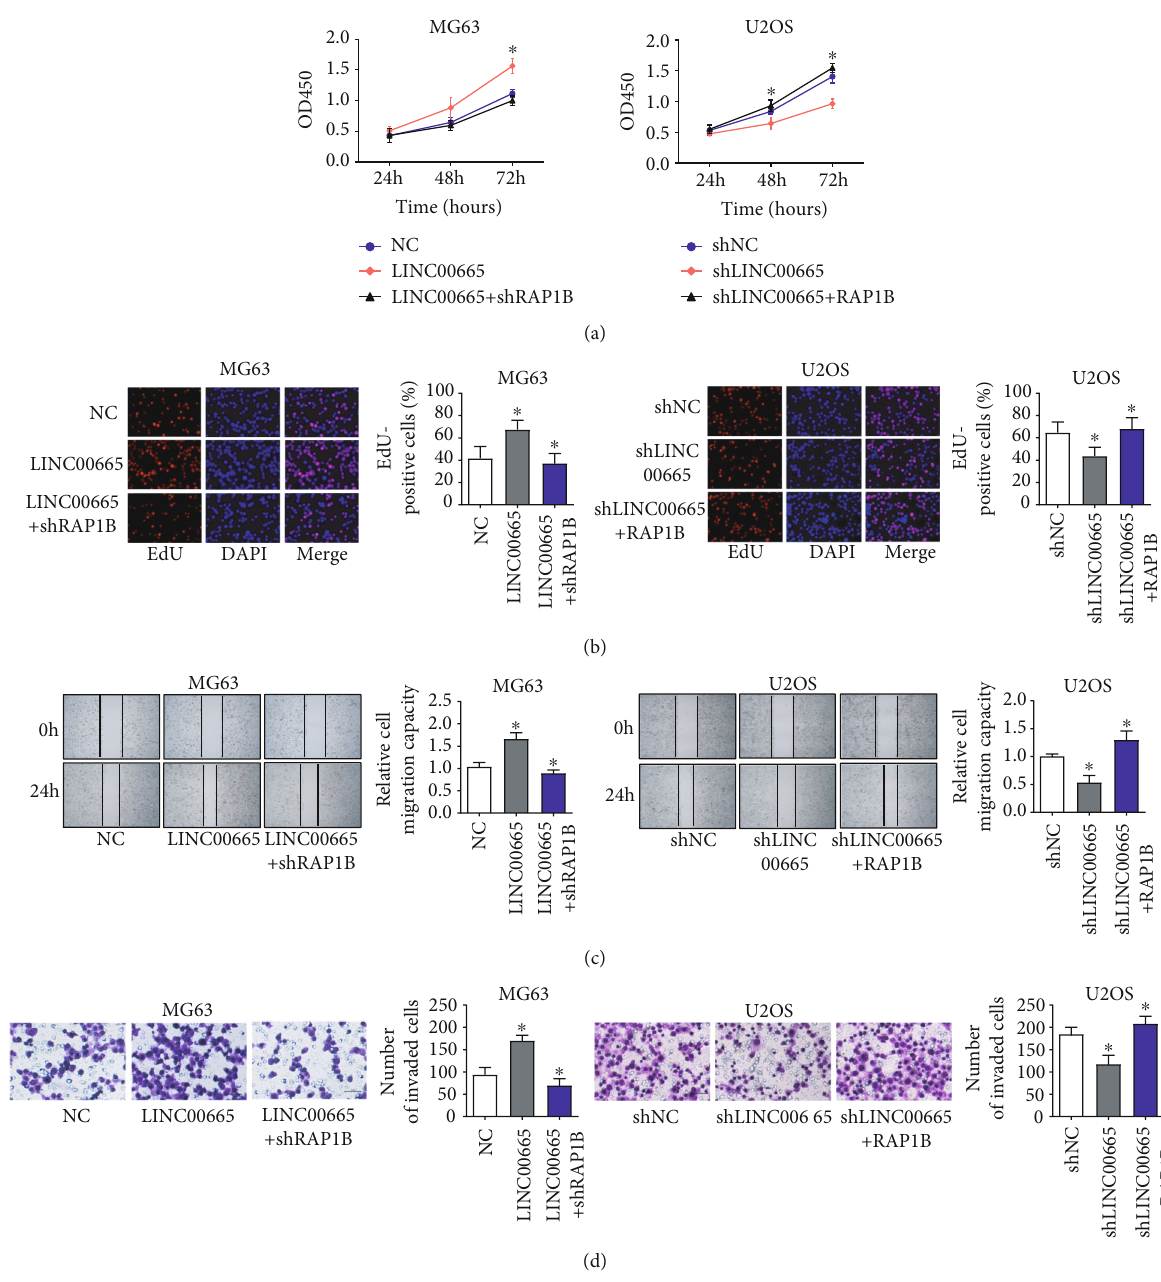
Figure 5: LINC00665 exercises its biological functions by mediating RAP1B. (a, b) CCK8 (a) and EdU assays (b) showed the regulation of LINC00665 and RAP1B on proliferation of OS cells. (c) Wound-healing assays showed the in fl uence of LINC00665 and RAP1B on migration of OS cells; magni fi cation, 40 × . (d) Transwell assays displayed the in fl uence of LINC00665 and RAP1B on invasion of OS cells, magni fi cation, 100 × . ∗ P < 0 : 05